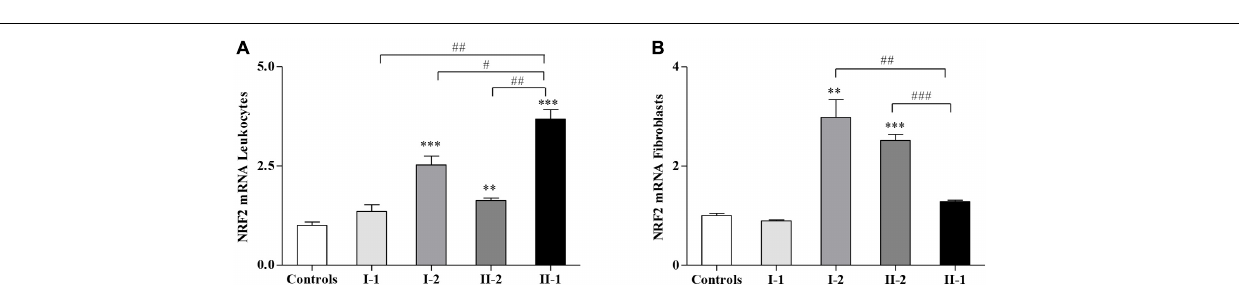
FIGURE 3 | Nuclear factor erythroid 2-related factor 2 ( NRF2 ) gene expression in Friedreich’s ataxia (FRDA) family. Quantitative real-time PCR (qRT-PCR) analysis of NRF2 transcripts in leukocytes (A) and in fibroblasts (B) of I-1, I-2, II-2, and proband II-1. Values represent median ± SEM. Statistical significance was defined as ** p < 0.01 and *** p < 0.001 with respect to the controls; and # p < 0.05, ## p < 0.01, and ### p < 0.001 compared with proband